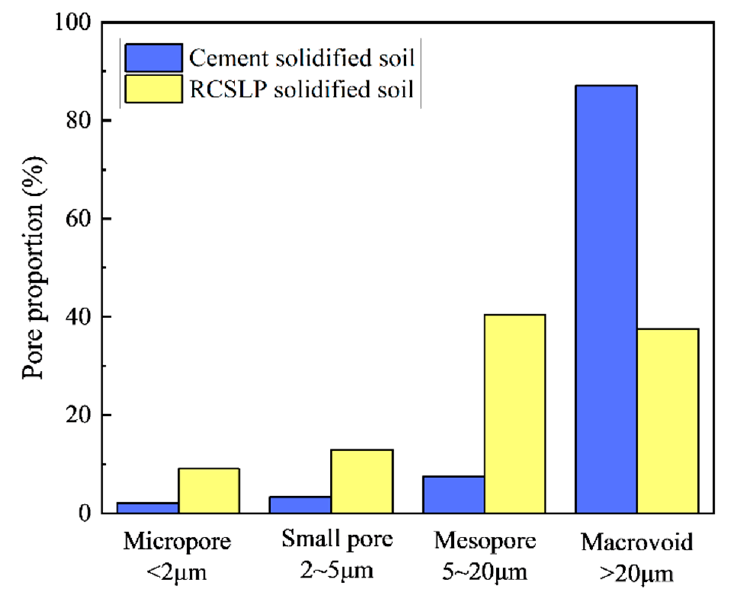
Figure 19. Surface porosity of the solidified soil.